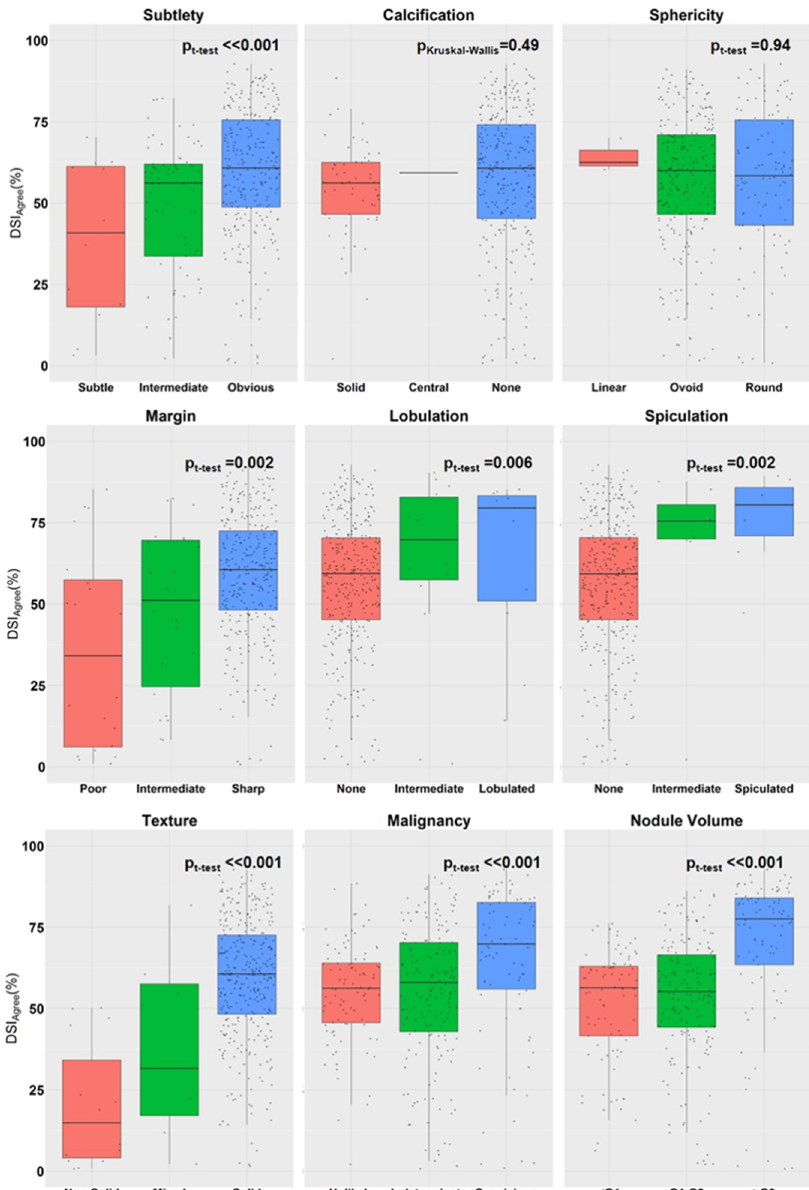
Fig 5. The relationships between nodule characteristics, nodule volume, and DSI Agree . This figure highlightsthe relationshipsbetweennodulecharacteristics, nodulevolume, and DSI Agree . Calcification: Solid = solid calcification,Central= central calcification,None = no calcification.Lobulation:None = not lobulated. Spiculated:None = not spiculated. Texture: Mixed = Semi-solid nodules. Malignancy: Unlikely= unlikelyfor cancer, Suspicious = suspiciousfor cancer. NoduleVolume: Q1 = 162ml, Q1– Q3 = 162ml to 796ml, and Q3 = 796ml; Q = quantile. malignancy, subtlety, calcification, lobulation, and spiculation were positively and significantly correlated to V (p range = 6.87x10 -27 –1.12x10 -4 ). t-test manual As image voxel thickness increased from 1 mm to 5 mm, the median DSI increased Agree from 62% to 79%. However, of the 354 CT images, only two images had a thickness of 5 mm. After excluding these two images from the analysis, the influence of image thickness on the